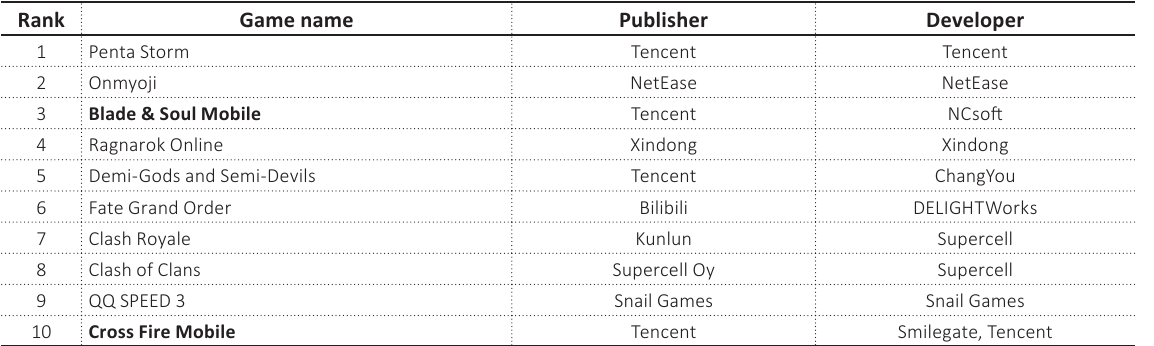
Table 3. 2018 Rank of mobile games in